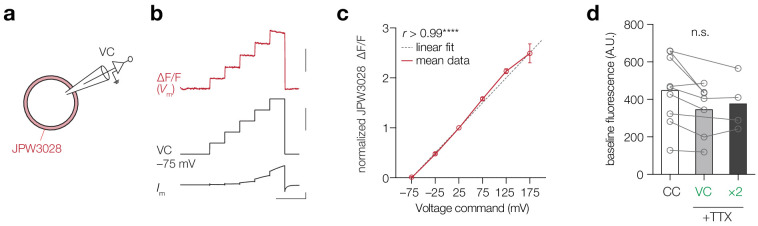
JPW3028 fluorescence linearly increases with membrane potential over a wide range of voltages.(a) Schematic of the experiment; whole-cell voltage clamp of HEK-293 cells filled with 0.8 mM JPW3028. (b) Top, example ∆F/F JPW3028 trace (red), middle, voltage command potentials, bottom, recorded current. Slow outward rectification was visible with depolarizing steps > 150 mV. Scale bars, from top to bottom: 1% ∆F/F, 100 mV, 2 nA, 200 ms. (c) Mean ∆F/F of the first 20 frames of each voltage step normalized to ∆F/F of the 100 mV step plotted versus the applied voltage revealed a highly linear relationship between Vm and ∆F/F, with r indicating Pearson’s correlation coefficient, ****p<0.0001, n = 3. Grey dotted line is a linear fit between voltage –75 and +25 (approximate Vm range of an AP), data plotted as mean (red line and open circles)± s.e.m. (d) The baseline fluorescence of JPW presented in Figure 5 remained stable throughout the recording. One-way ANOVA, p=0.45, Tukey’s multiple comparisons test, CC (n = 9) vs. VC (n = 7), p=0.44, CC vs. VC × 2 (n = 4), p=0.74, VC vs. VC × 2, p=0.95. Data available in Figure 5—source data 1.